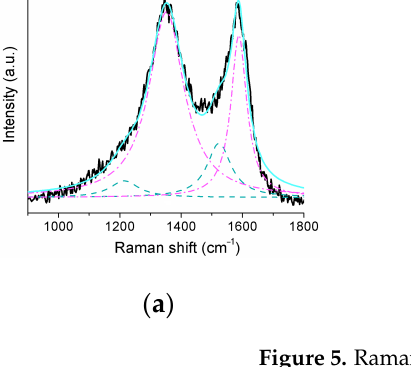
(3) Figure 4. Thermogravimetric curve (TG) and ion currents with numbers (M/z) 46, 44, and 30 vs. the temperature for LFP/C PANI -II. Raman spectra of N-CNTs, N-CNPs, and C PANI showed two intense bands at 1590